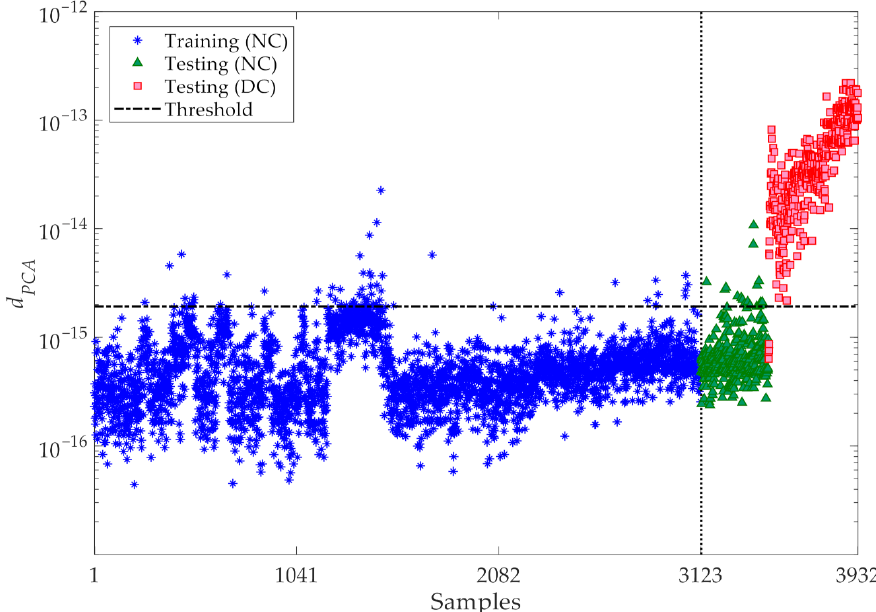
Figure 14. Z24 Bridge: damage detection via the classical PCA